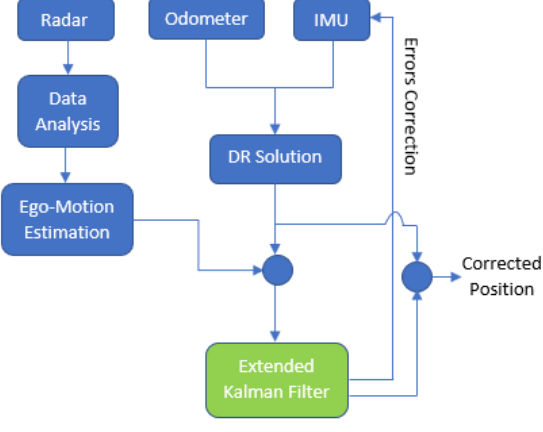
Figure 3. Block Diagram showing Radar/odometer/INS integration